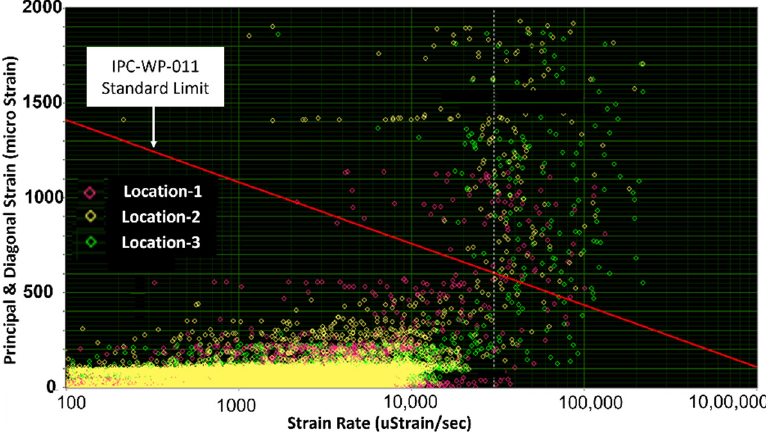
Figure 8. Strain gauge measurement data show that a part of the principal strain exceeds the IPC- WP-011 standard limits during the cutting process.